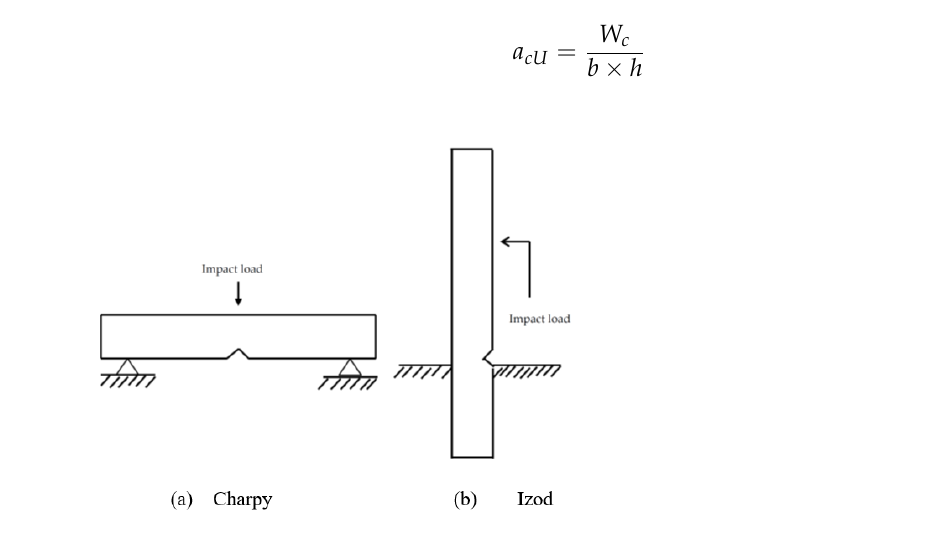
Figure 5. ( a ) Charpy (beam load) and ( b ) Izod (cantilever beam load). Adapted from